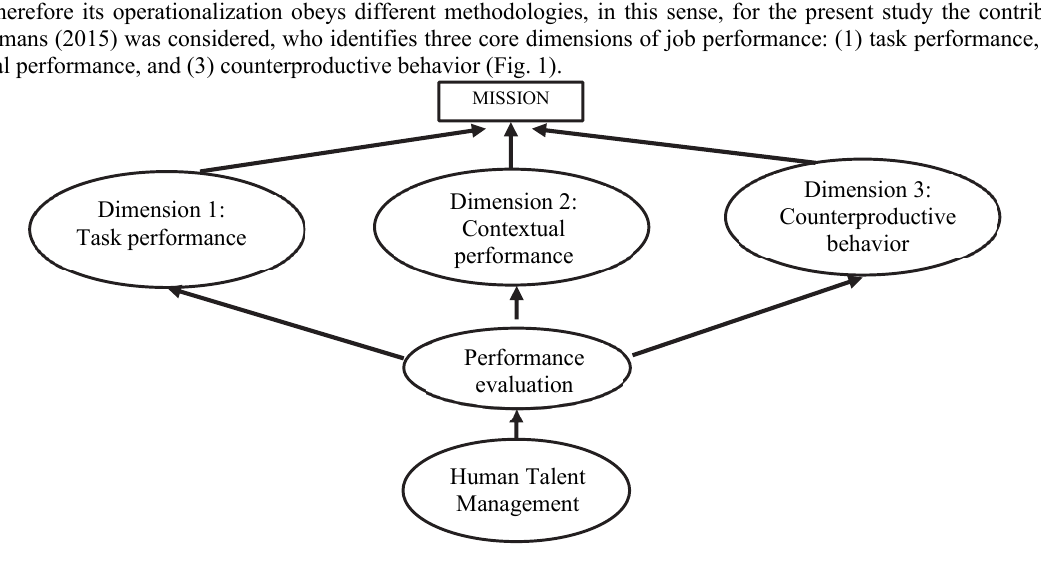
Fig. 1. Performance evaluation as a